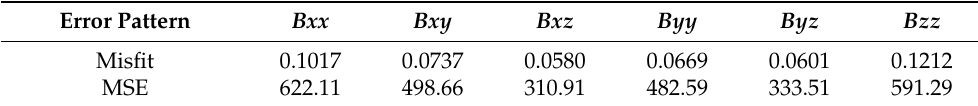
Table 7. Rectangle_2B model’s prediction Misfit and